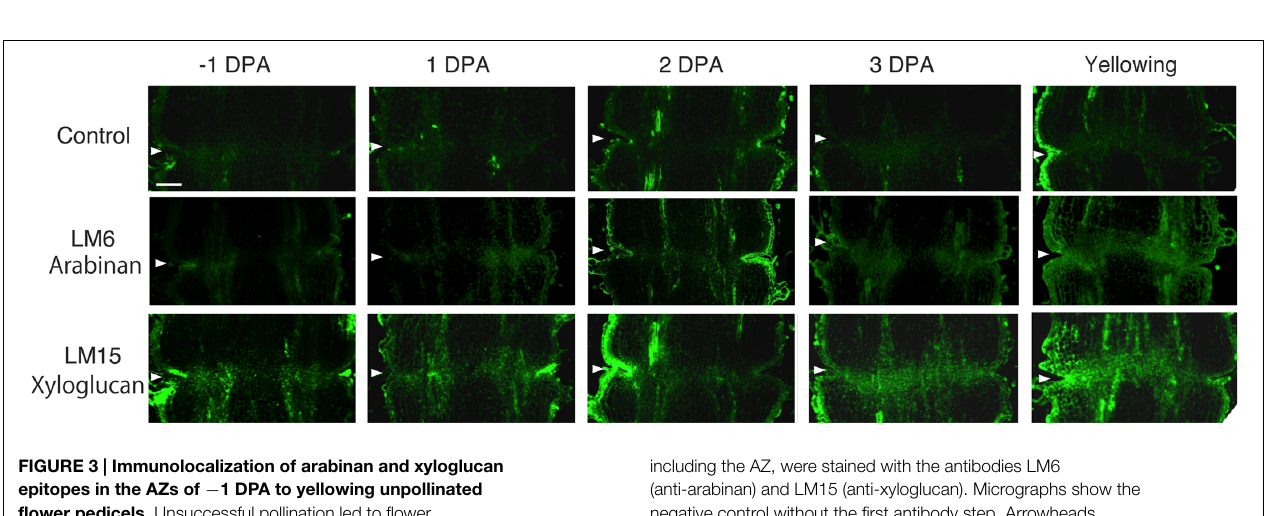
including the AZ, were stained with the antibodies LM6 (anti-arabinan) and LM15 (anti-xyloglucan). Micrographs show the negative control without the first antibody step. Arrowheads indicate the AZs. Bar = 0.2